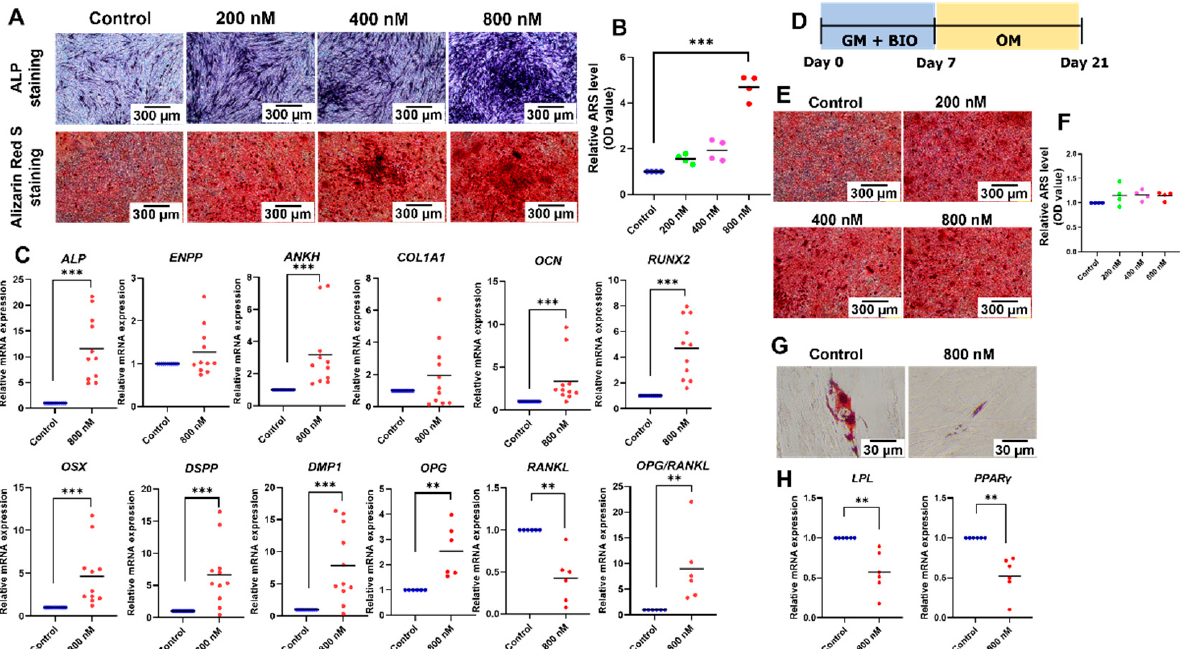
Figure 3. BIO promotes odonto/osteogenic differentiation but attenuates adipogenic differentiation of hDPSCs. ( A ) Osteogenic differentiation was determined by alkaline phosphatase (ALP) staining and mineral deposition. Scale bars: 300 µm. ( B ) Quantifying ARS staining. ( C ) The mRNA levels of osteogenic-related marker genes. ( D ) Timeline representing the pretreatment effect experiment. ( E ) Osteogenic differentiation was determined by mineral deposition. Scale bars: 300 µm. ( F ) Quantification of ARS staining. ( G ) Adipogenic differentiation was evaluated by intracellular lipid deposition. Scale bars: 30 µm. ( H ) The mRNA levels of adipogenic-related marker genes. Bars indicate a significant difference between groups (** p < 0.01. *** p < 0.001).